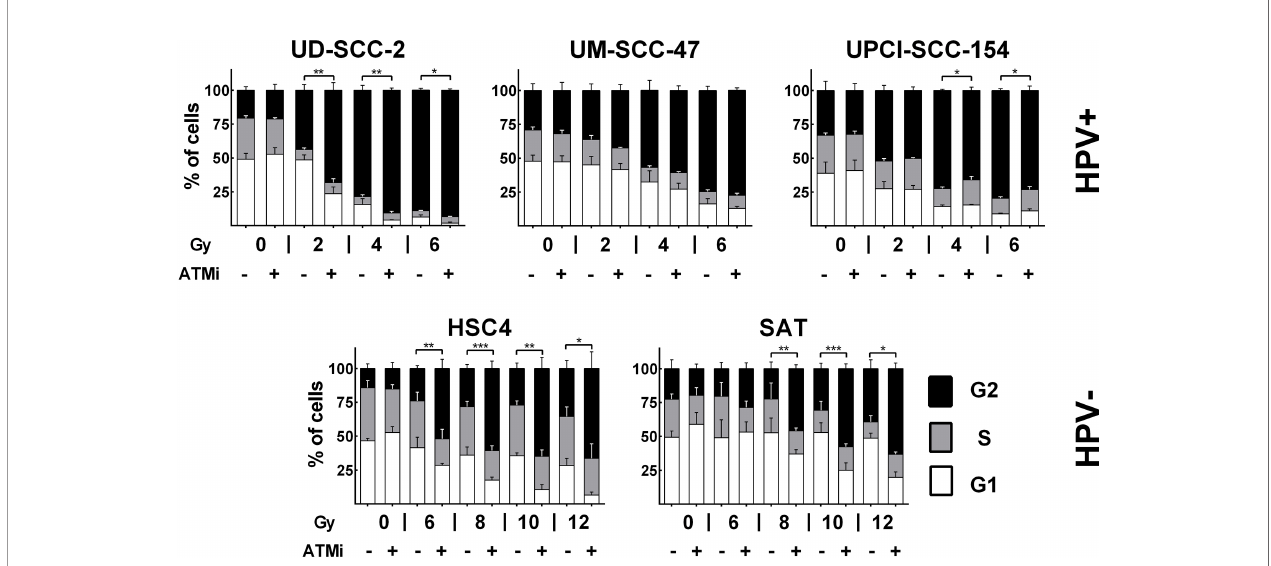
FIGURE 2 | Radiation-induced G2 arrest. Cells were treated for 30 min with the ATM inhibitor before irradiation, as indicated. 24 h after irradiation the cells were fi xed and the cell cycle distribution assessed by DAPI staining and fl ow cytometry. Statistical evaluation was performed for changes in the fraction of G2 phase cells upon ATM inhibition. Asterisks depict signi fi cant differences with *, **, and *** indicating p < 0.05, p < 0.01, and p < 0.001 (two-tailed Student ’ s t-test).